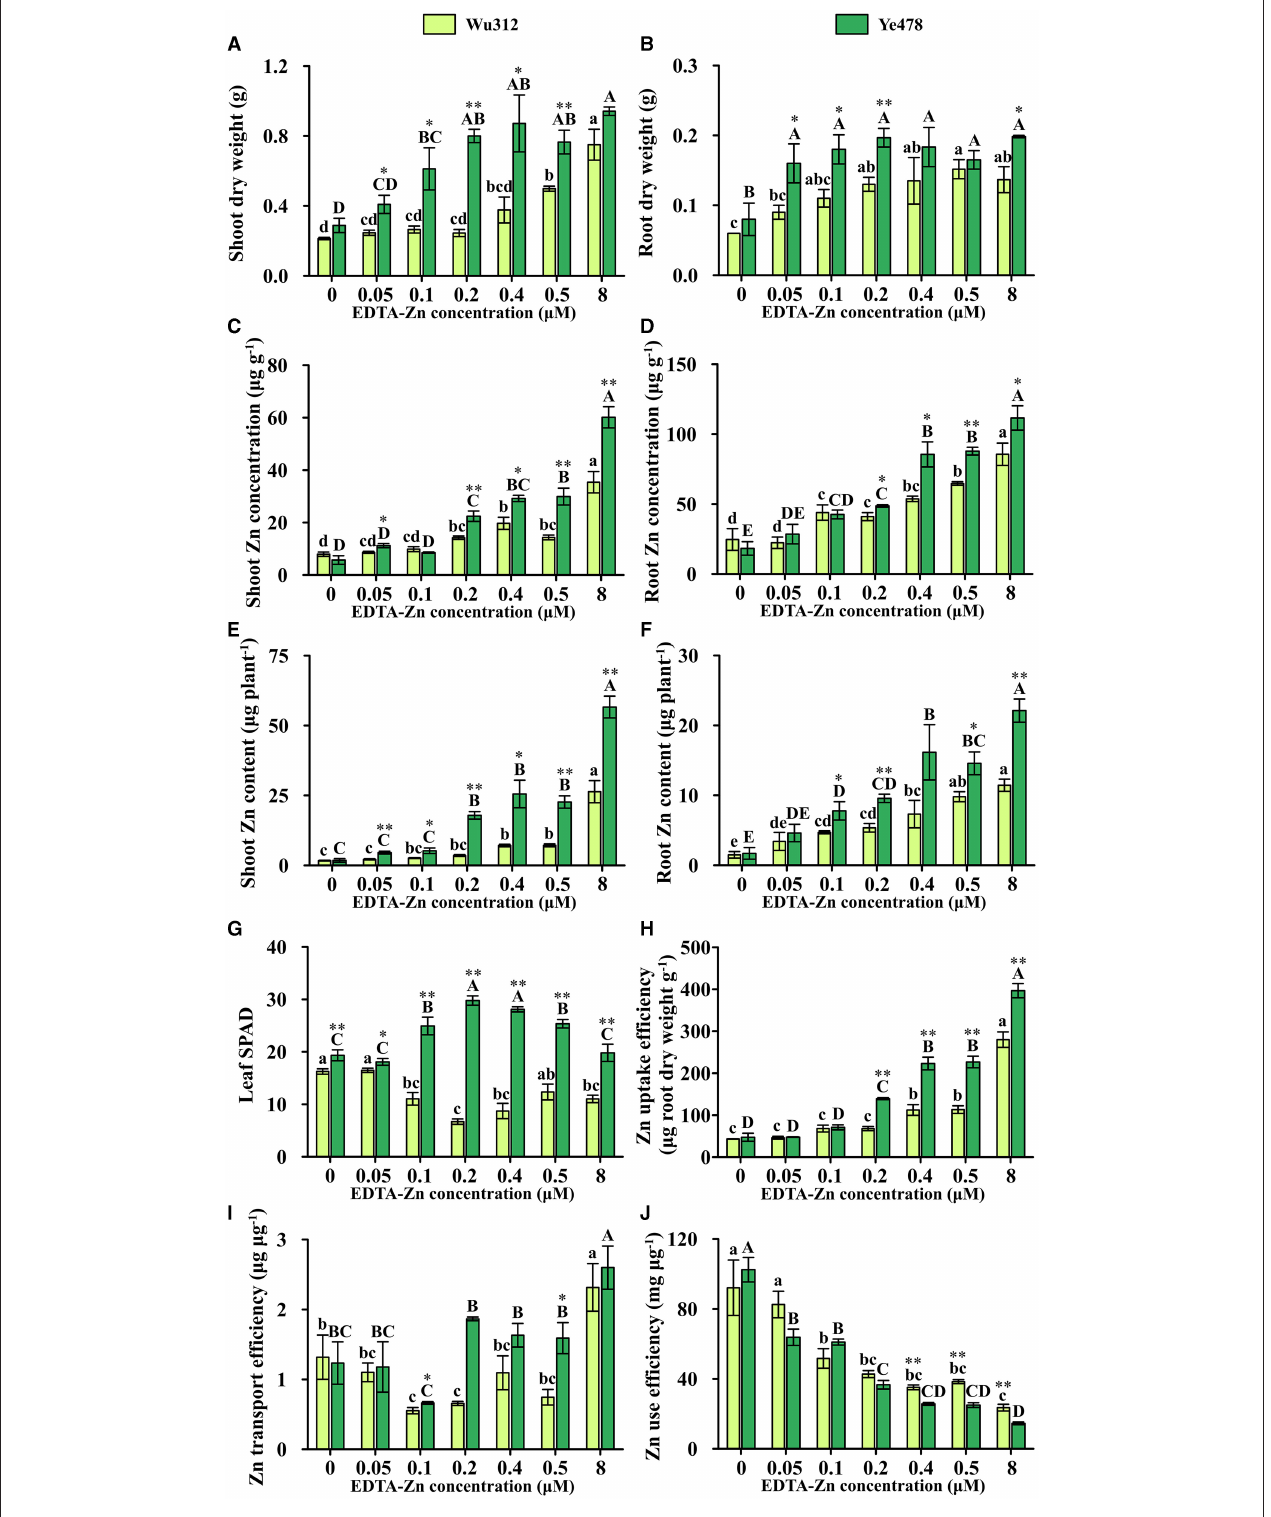
FIGURE 2 | Shoot (A) and root (B) dry weight, shoot (C) and root (D) Zn concentration, shoot (E) and root (F) Zn content, leaf SPAD (G) , Zn uptake efficiency (H) , Zn transport efficiency (I) and Zn use efficiency (J) of Zn-sensitive inbred line Wu312 and Zn-tolerant inbred line Ye478 in Experiment 1. Different lowercase and upper letters indicate significant difference ( p < 0.05) of Wu312 and Ye478 among treatments, respectively. * and ** indicate significant difference between Wu312 and Ye478 at p < 0.05 and p < 0.01, respectively.